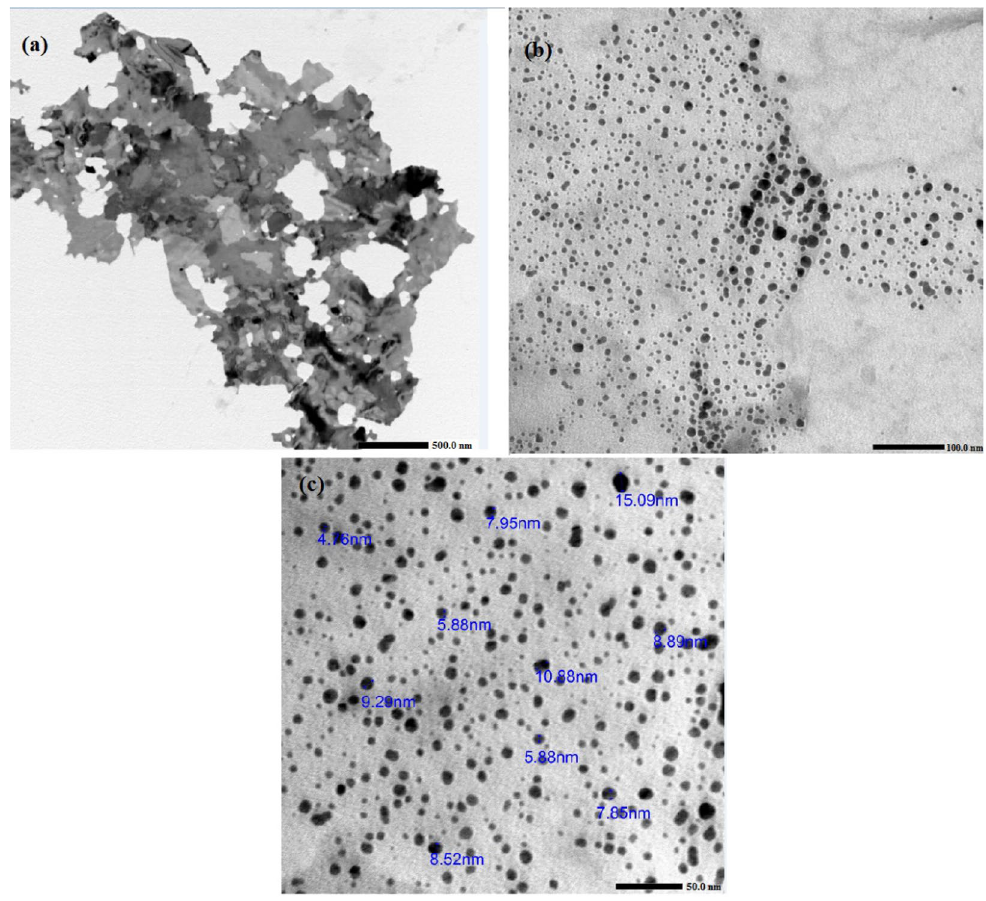
Figure 6. TEM images of Ag/ZnO@BC at 500 nm ( a ), 100 nm ( b ), and 50 nm ( c )